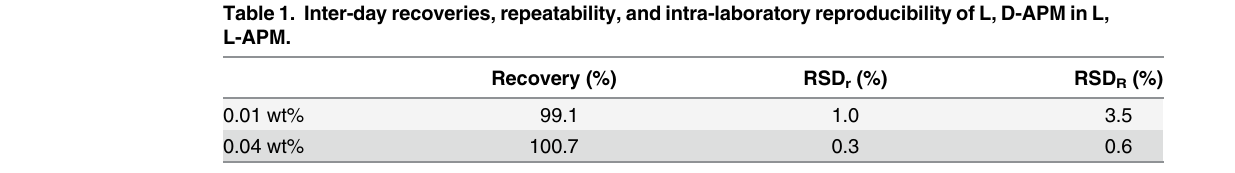
RSD R are calculated by one-way analysis of variance of the recovery values obtained on fi ve different